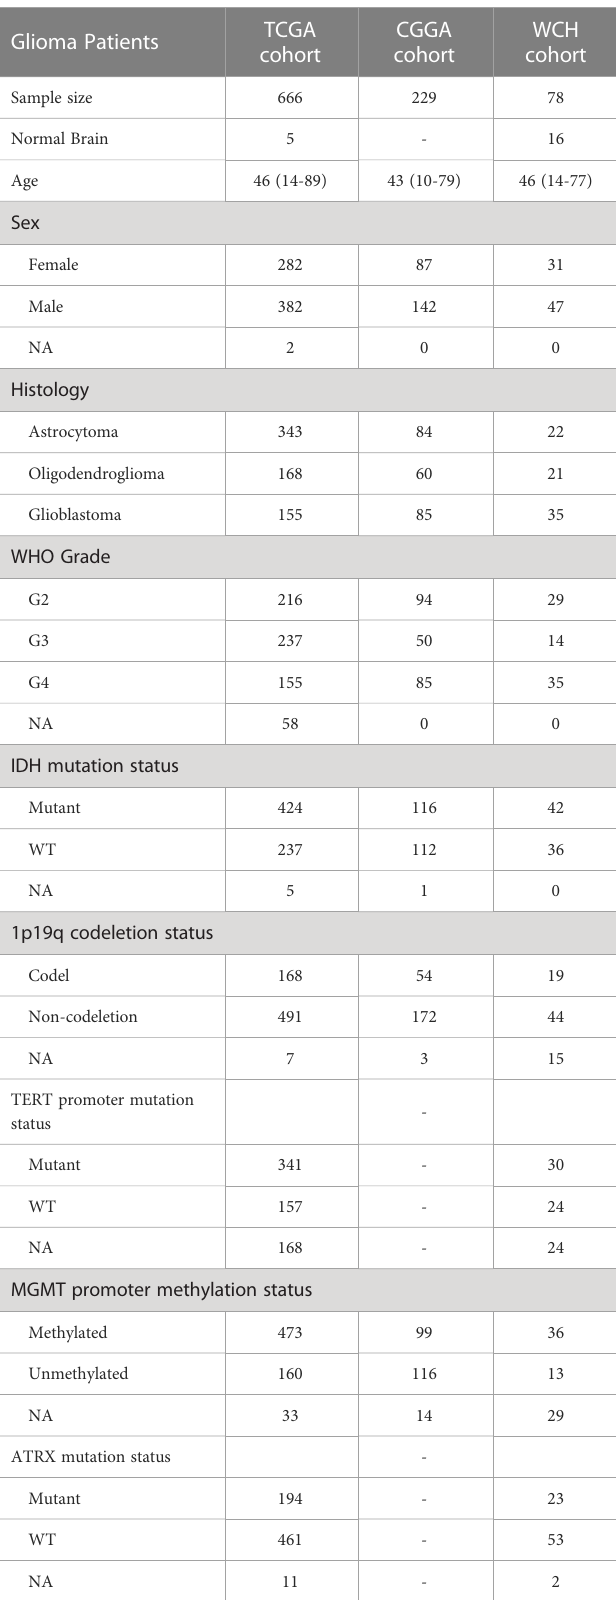
TABLE 1 Clinicopathological characteristics of glioma patients in TCGA, CCGA, and WCH